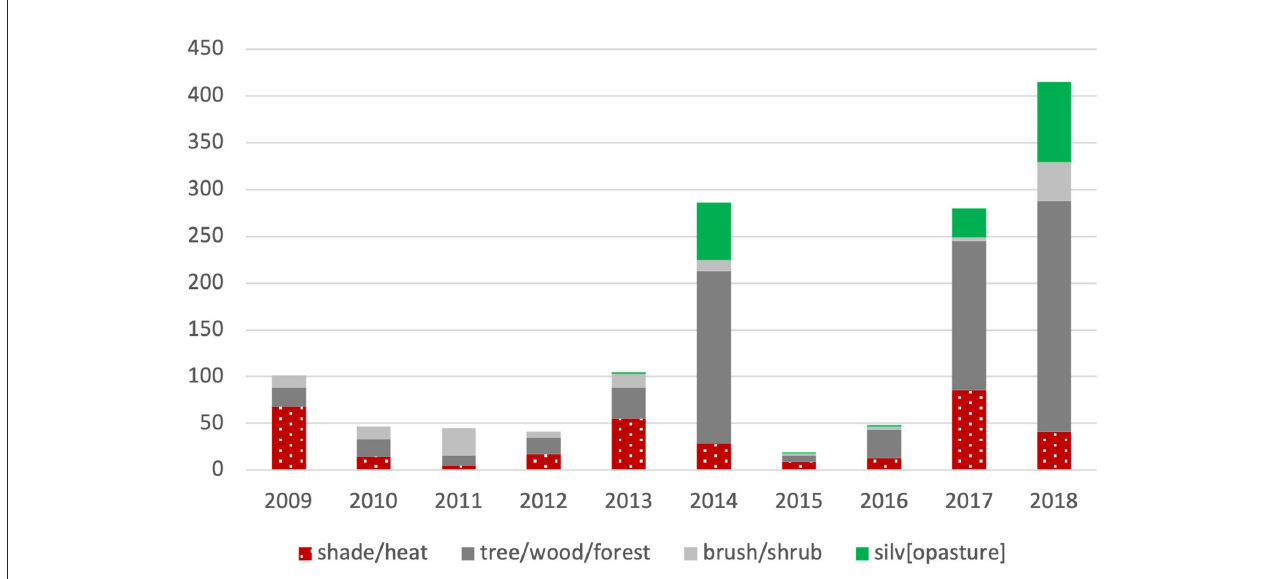
FIGURE3 Occurrence of search terms in Graze related to integrating management of trees, pasture, and livestock. 2009, 2013, and 2017 had special features on managing heat